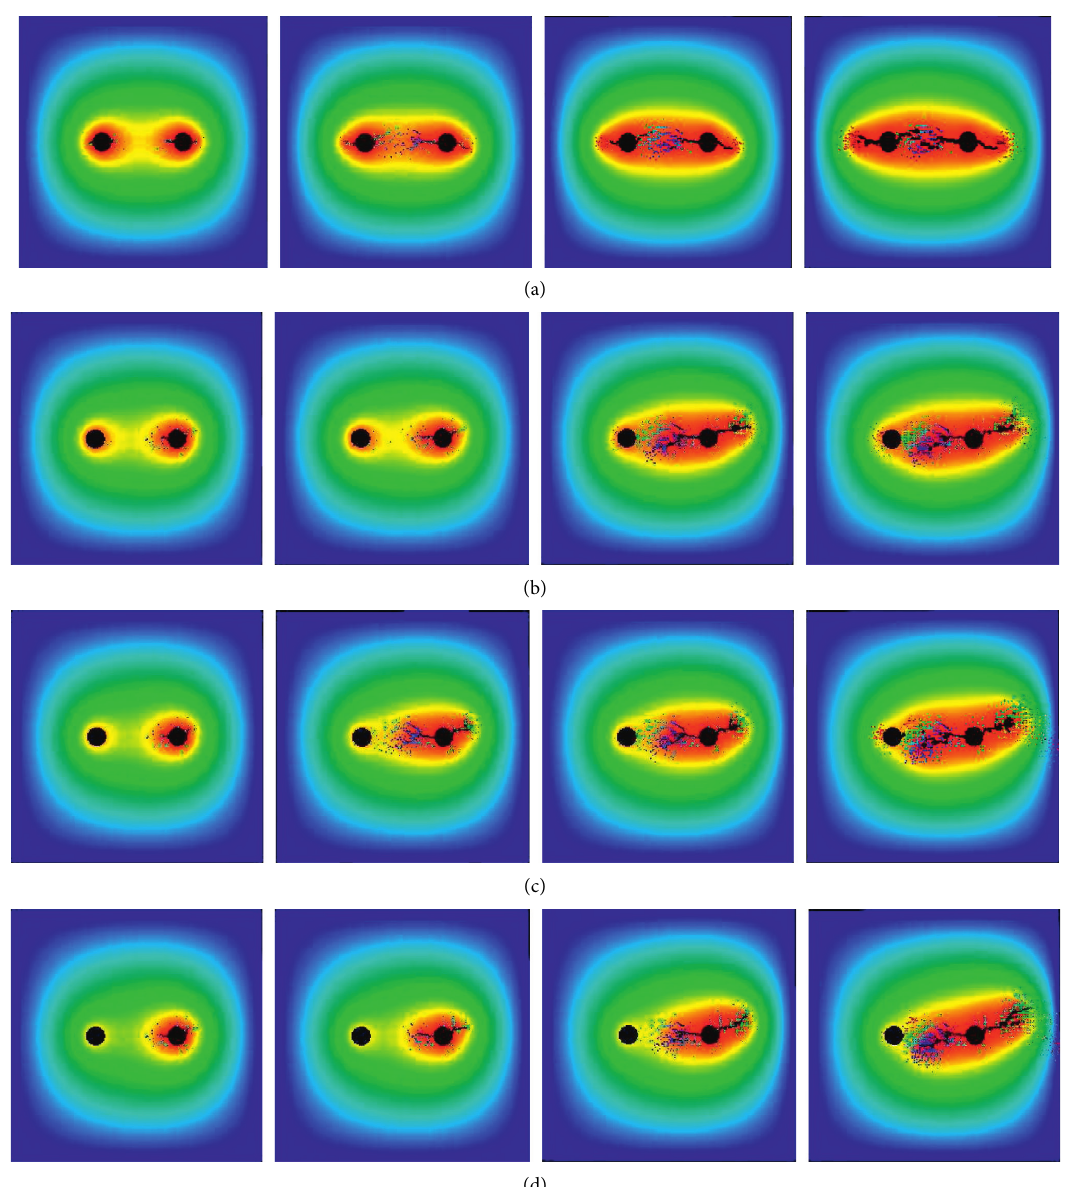
Figure 11: Numerically simulated failure evolution of two wellbores due to unequal hydraulic pressures in left hole and right hole ( m � 2, K � 1, and L � 130mm). (a) The initial pore pressure of holes 1 and 2 is 10MPa, and the incremental pore pressure is 0.5 MPa. (b) The initial pore pressure of holes 1 and 2 is 10 and 13MPa, and the incremental pore pressure is 0.5MPa. (c) The initial pore pressure of holes 1 and 2 is 10 and 15MPa, and the incremental pore pressure is 0.5 MPa. (d) The initial pore pressure of holes 1 and 2 is 10 and 17 MPa, and the incremental pore pressure is